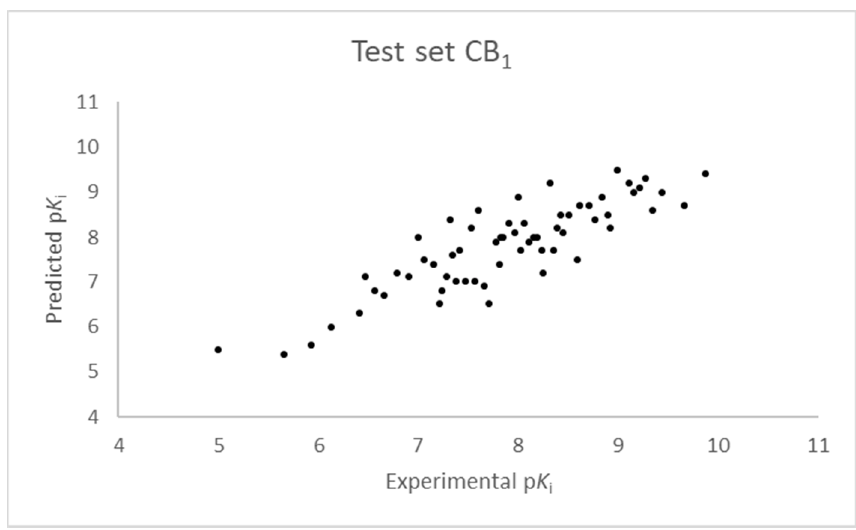
Figure 3. Ten component 3D-QSAR model experimental vs. predicted p K i of the compounds in the test set for the CB 1 receptor.